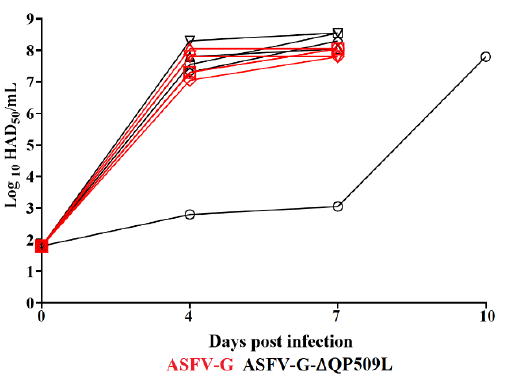
Figure 7. Viremia titers were detected in pigs IM inoculated with 10 2 HAD 50 of either ASFV-G- ∆ QP509L or ASFV-G. Each curve with a different shape represents individual animal titers. The sensi- tivity of virus detection: >log10 1.8 TCID 50 /mL. No significant differences in the evolution of viremia were found between groups when analyzed by the unpaired t -test using the two-stage step-up (Benjamin, Krieger, and Yekutieli) method.